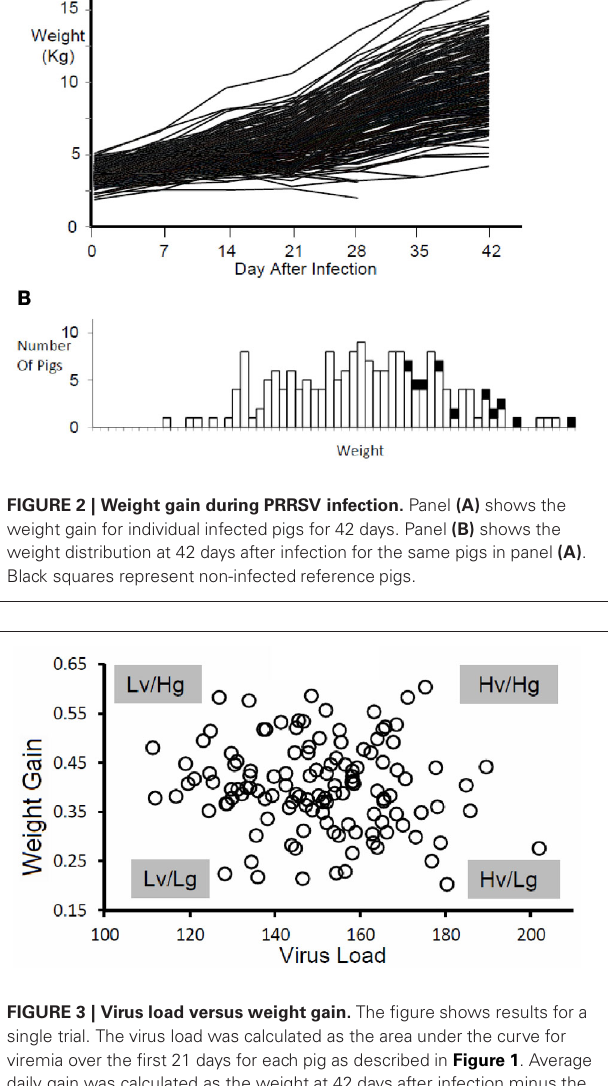
FIGURE 1 | Viremia following PRRSV infection. Viremia was measured by RT-PCR of viral RNA using a commercial diagnostic PRRSV assay. For the purpose of standardization, the results were reported as number of PRRSV templates per 50ul PCR reaction. Results are shown for those pigs in a single 200 pig trial that possessed data for all days.